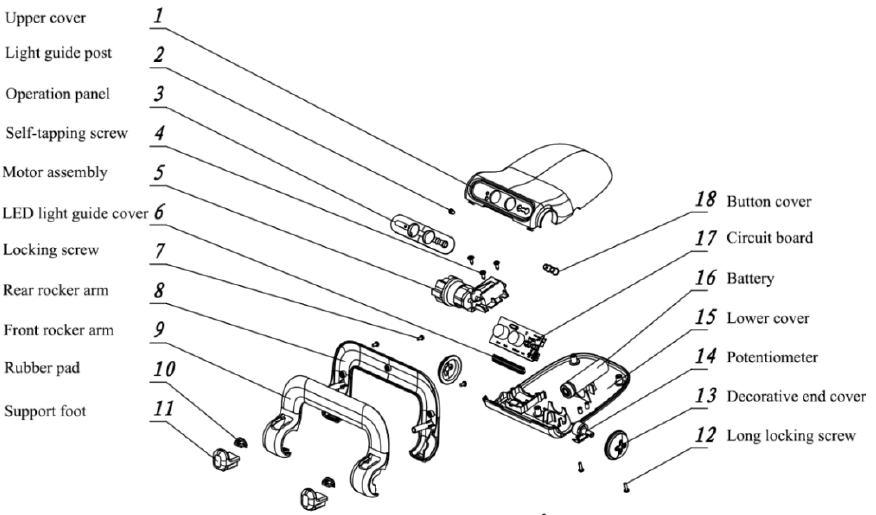
Figure 4. Structural explosion diagram of the self-accommodating vision protection